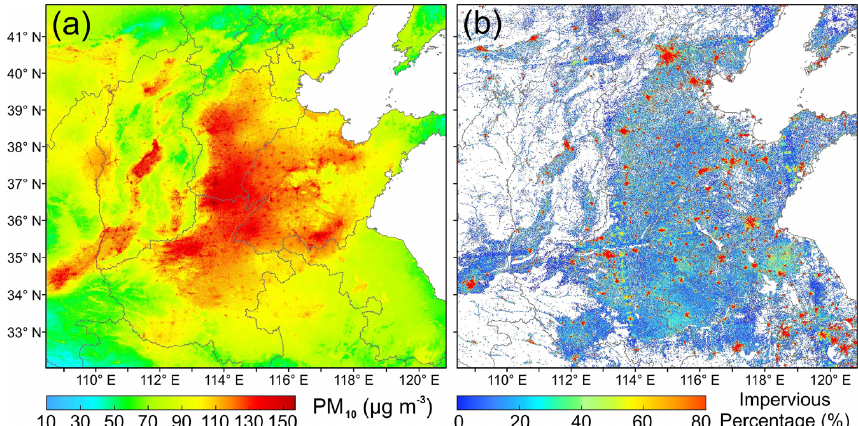
Figure 9. Comparison of annual mean PM 10 concentration with the proportion of areas coved by impervious surface in eastern